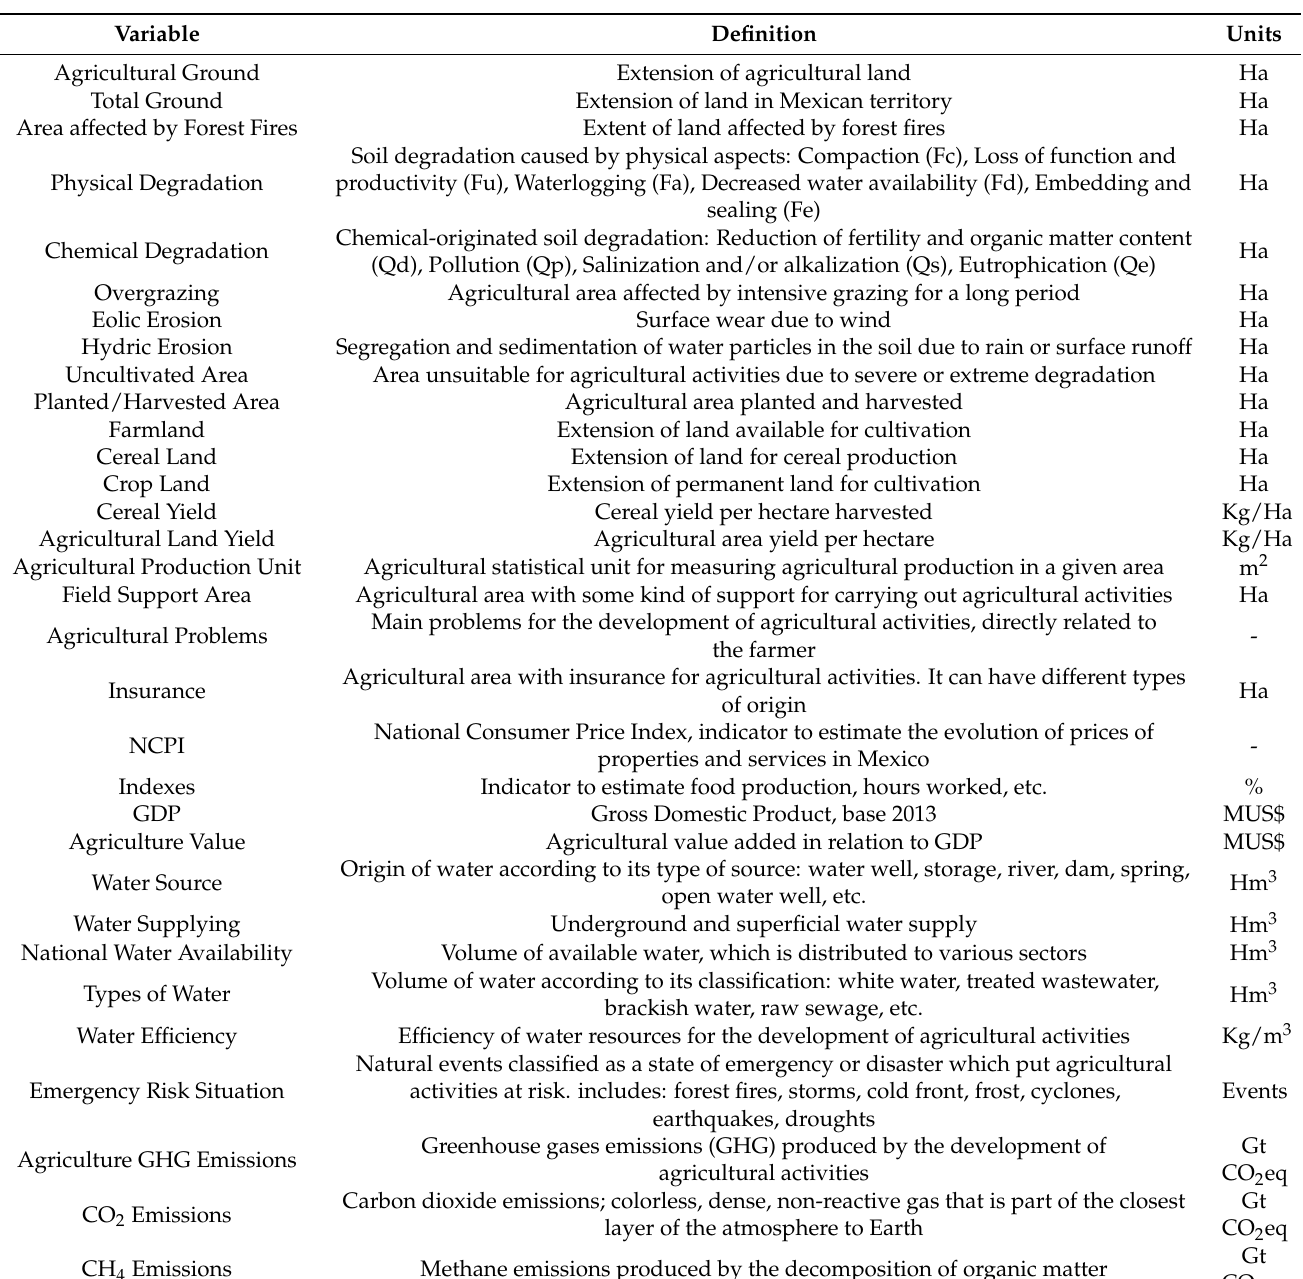
Table 2. Variables of vulnerability indicators agent